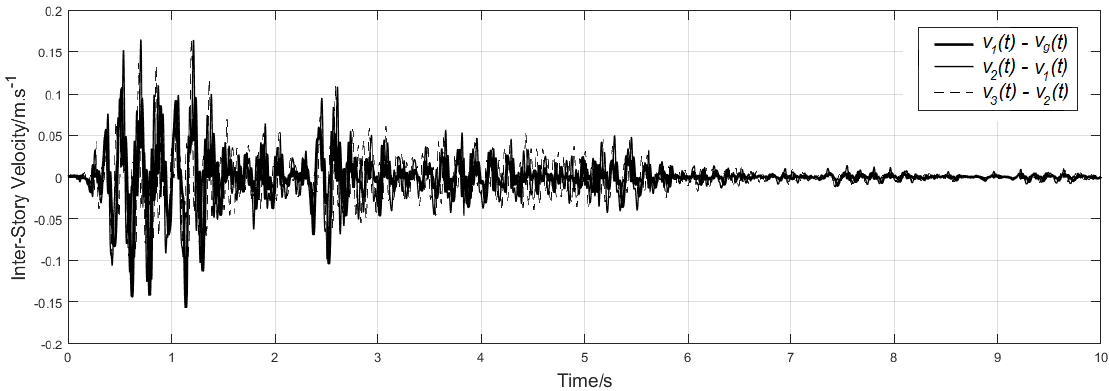
Figure 9. The building closed-loop displacement response to the earthquake, assuming an empirically tuned BELBIC controller.